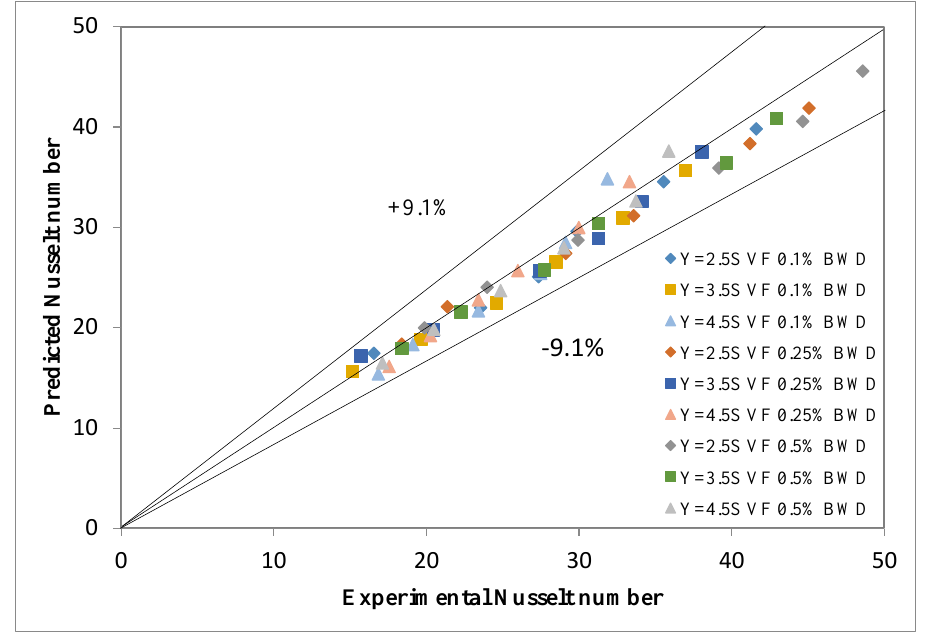
Figure 17. Predicted versus experimental Nusselt number for a staggered conical strip insert with the backward arrangement using deionized water and ZrO 2 / deionized water nanofluids under laminar flow conditions.